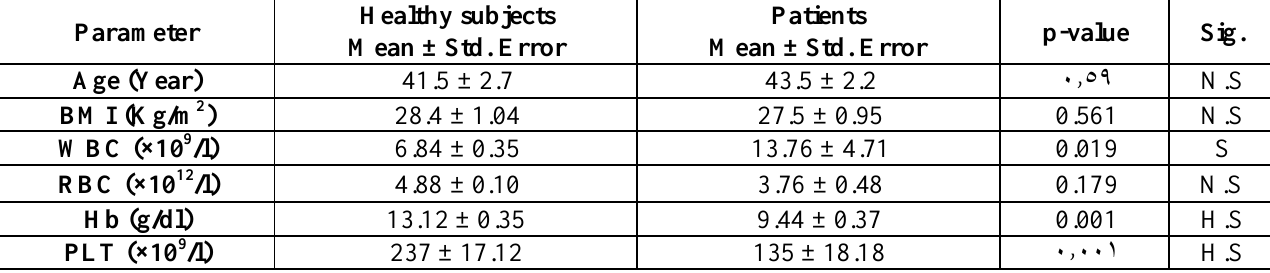
Table 1: Demographic and hematological features of leukemia patients and healthy subjects